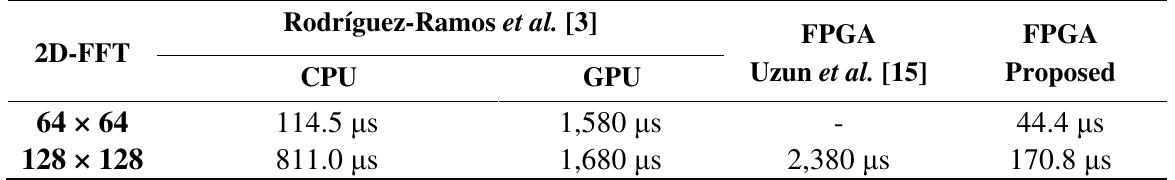
Table 1. 2D-FFT performance comparison with other designs.